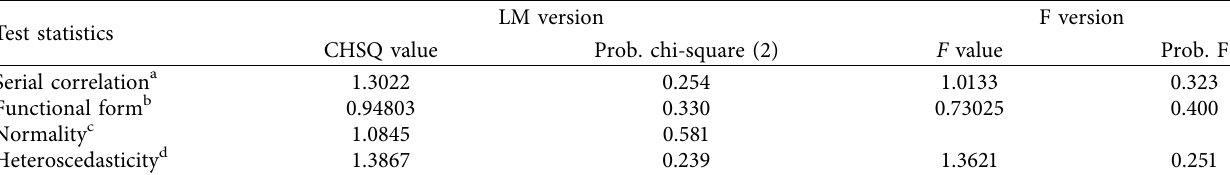
Table 3: Diagnostic